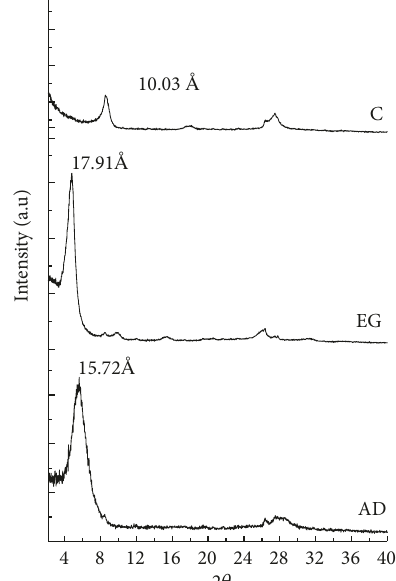
Figure 3: XRD pattern the clay fraction < 2 𝜇 m (oriented mounts): AD: air dried; EG: saturated with ethylene glycol vapor; C: calcined at 500 ∘